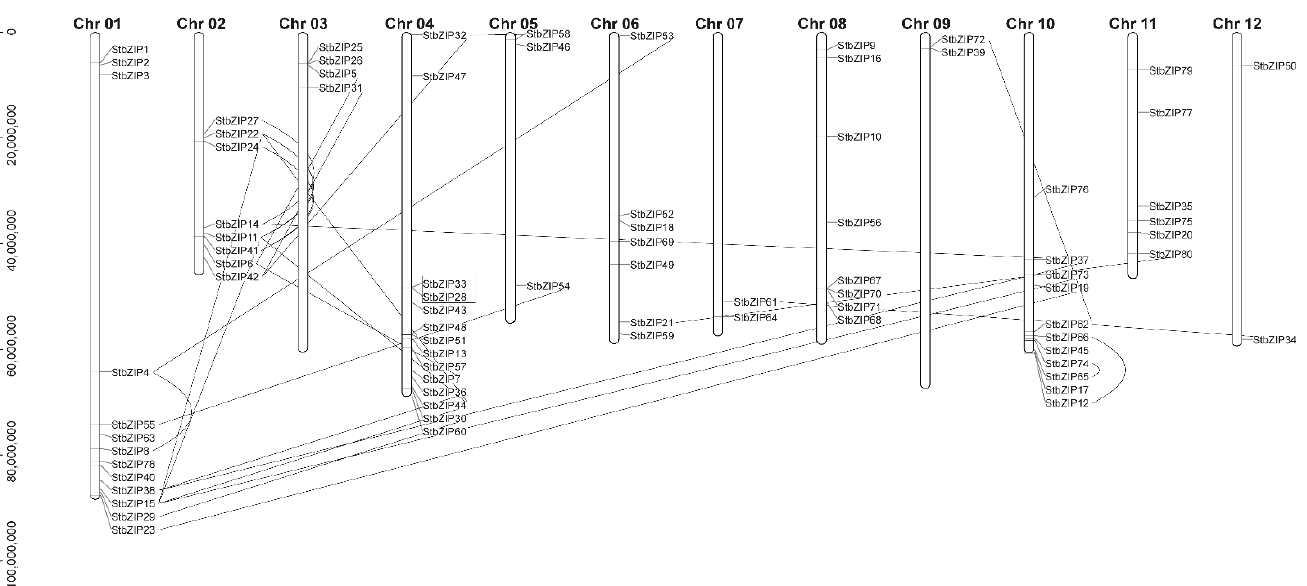
Table 2. The nonsynonymous (Ka) and synonymous (Ks) substitution ratio (Ka/Ks) test for 22 gene